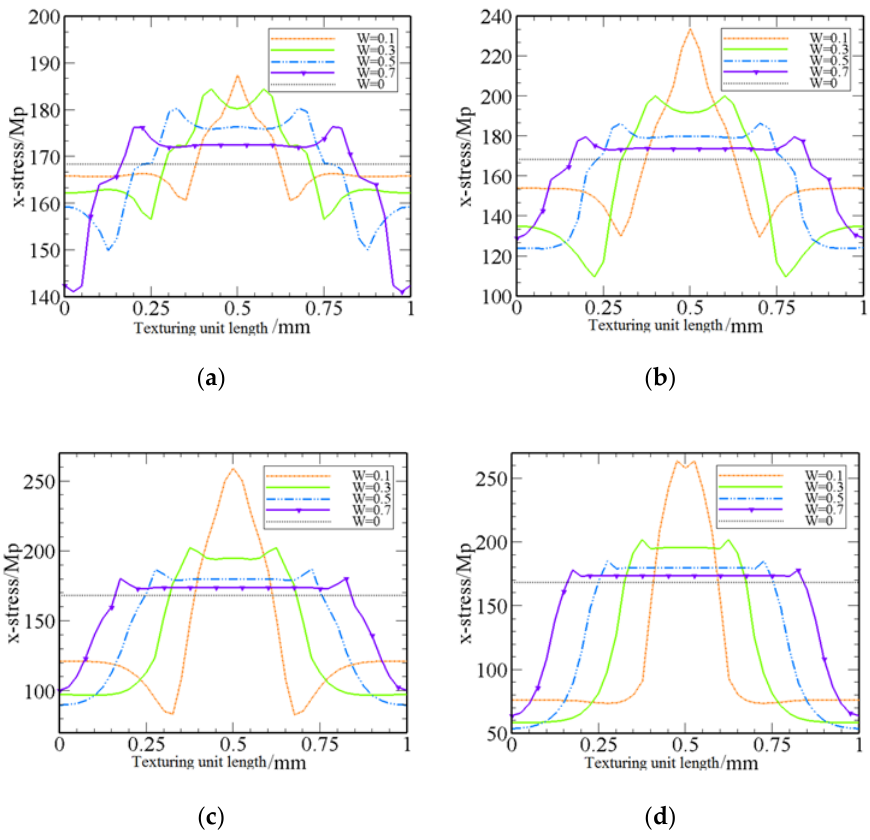
Figure 7. Distribution of stresses along the x –direction with different texturing widths. ( a ) H = 0.1; ( b ) H = 0.3; ( c ) H = 0.5; ( d ) H =